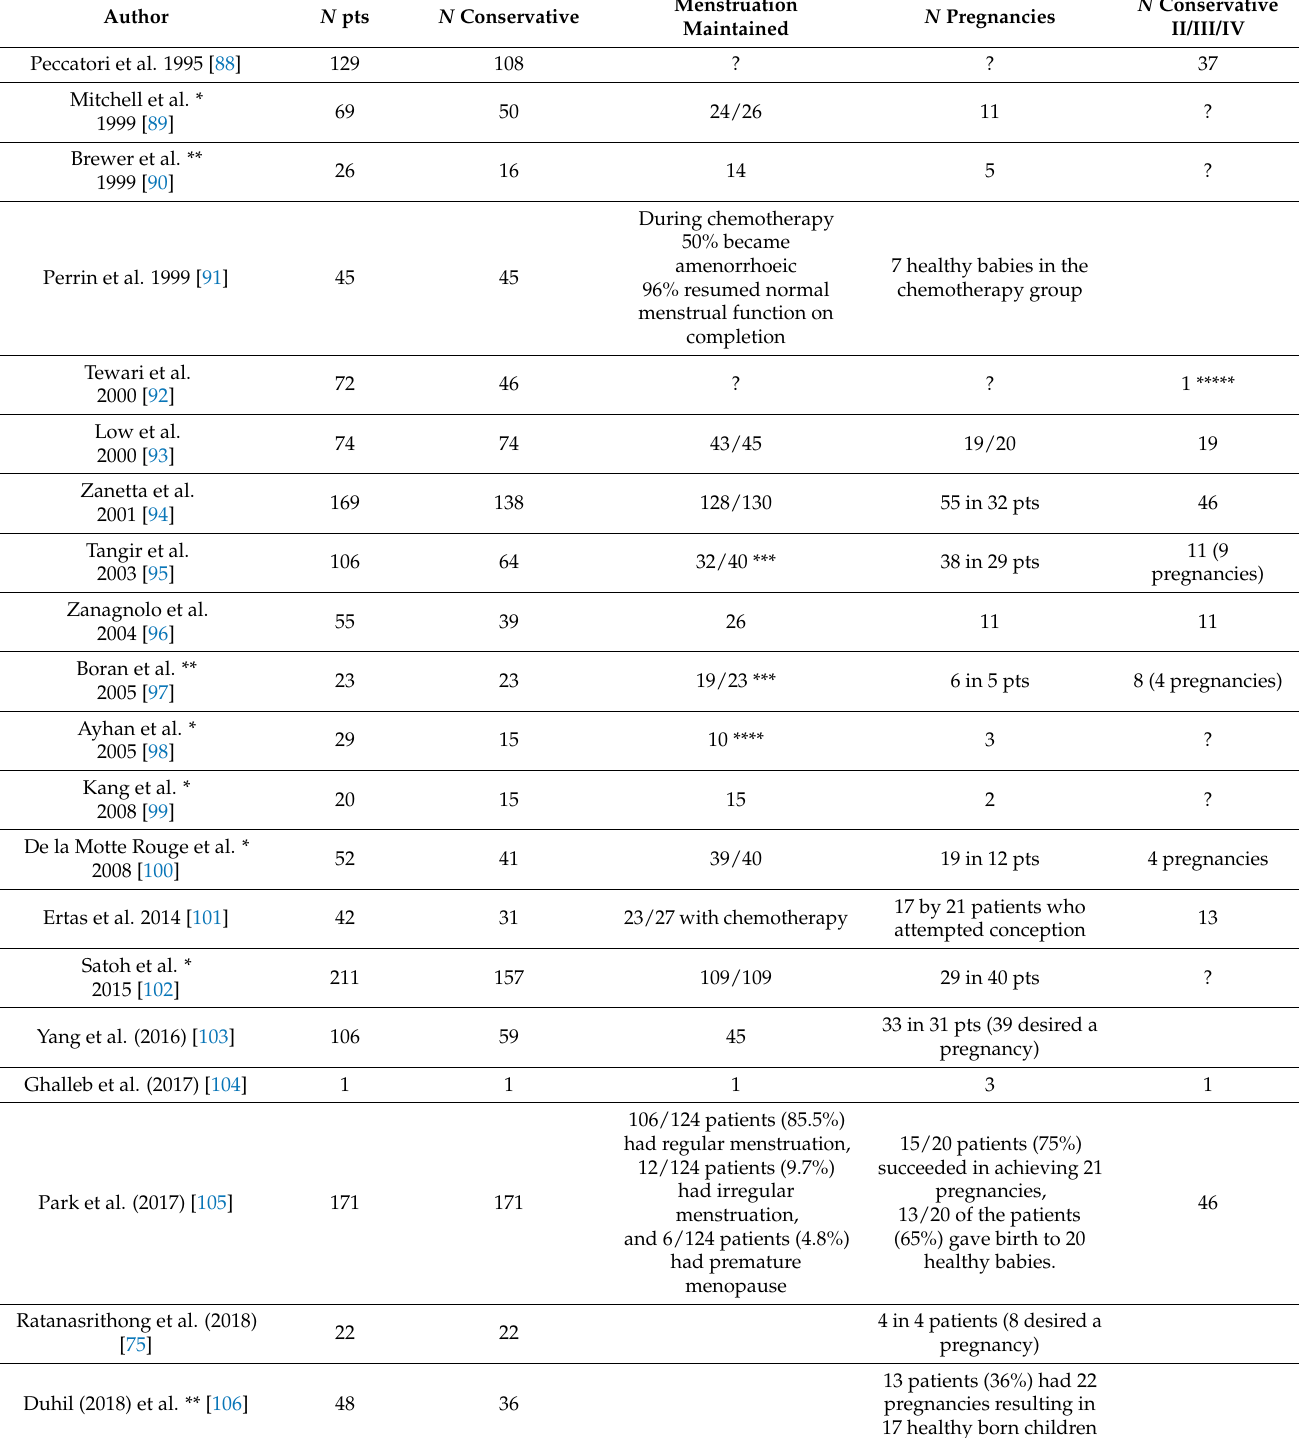
Table 4. Literature review of fertility outcomes after fertility-sparing surgery in germ cell tumors (series published after 1995).